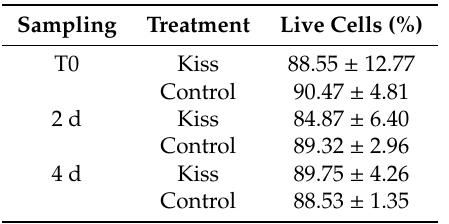
Figure 5. Gonadotropins plasma levels in ng/mL (mean ± SEM) from Senegalese sole males treated with kisspeptin hormone ( n = 17) and control ( n = 13). ( A ) Fsh and ( B ) Lh levels before (T0) and after (2 h: 2-h; 4 h: 4-h; 2 d: 2-days; 4 d: 4-days) the kisspeptin injection. The asterisk denotes significant differences between experimental groups at each sampling point (Student’s t -test; * p < 0.05; *** p < 0.001); different letters indicate significant differences among sampling points within each experimental group (one-way ANOVA, Dunnett’s test, p < 0.05, T0 considered as control point).